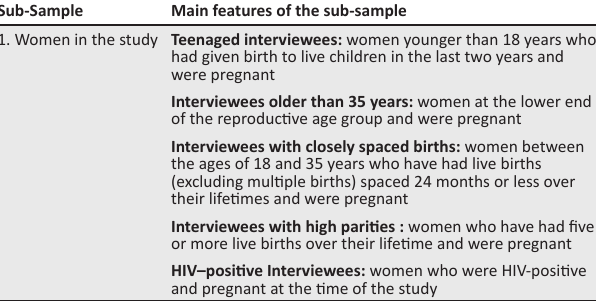
TABLE 1: Study population by sub-samples.